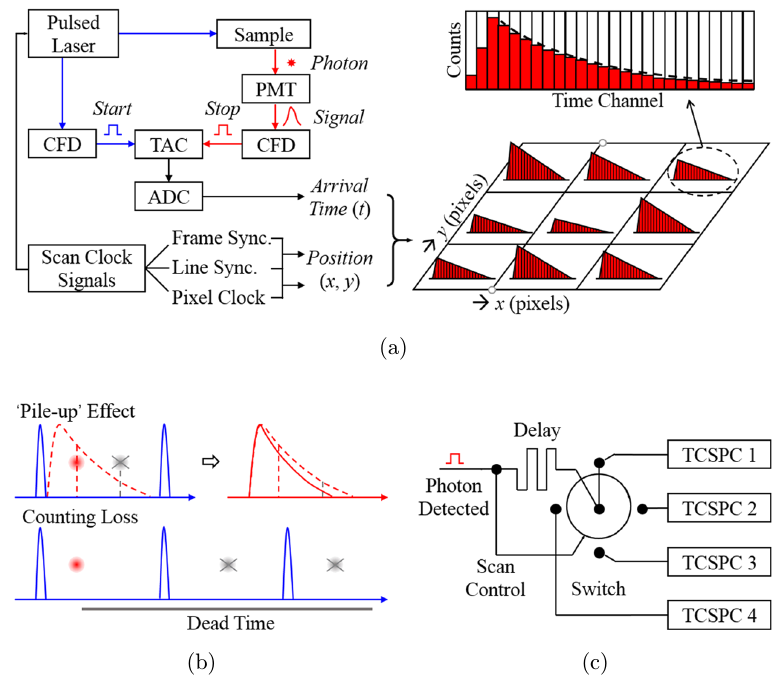
Fig. 2. (a) Principle of TCSPC-FLIM. CFD: constant fraction discriminator; TAC: time-to-amplitude converter; ADC: analog-to- digital converter; Sync.: synchronization. Photon distribution n ( x , y , t Þ is obtained and converted into FLIM image with data analysis. (b) Illustration of \pile-up" e®ect and counting loss in TCSPC-FLIM. The dash line indicates the real decay, the solid line measured. (c) Illustration of fast-acquisition FLIM with parallel TCSPC